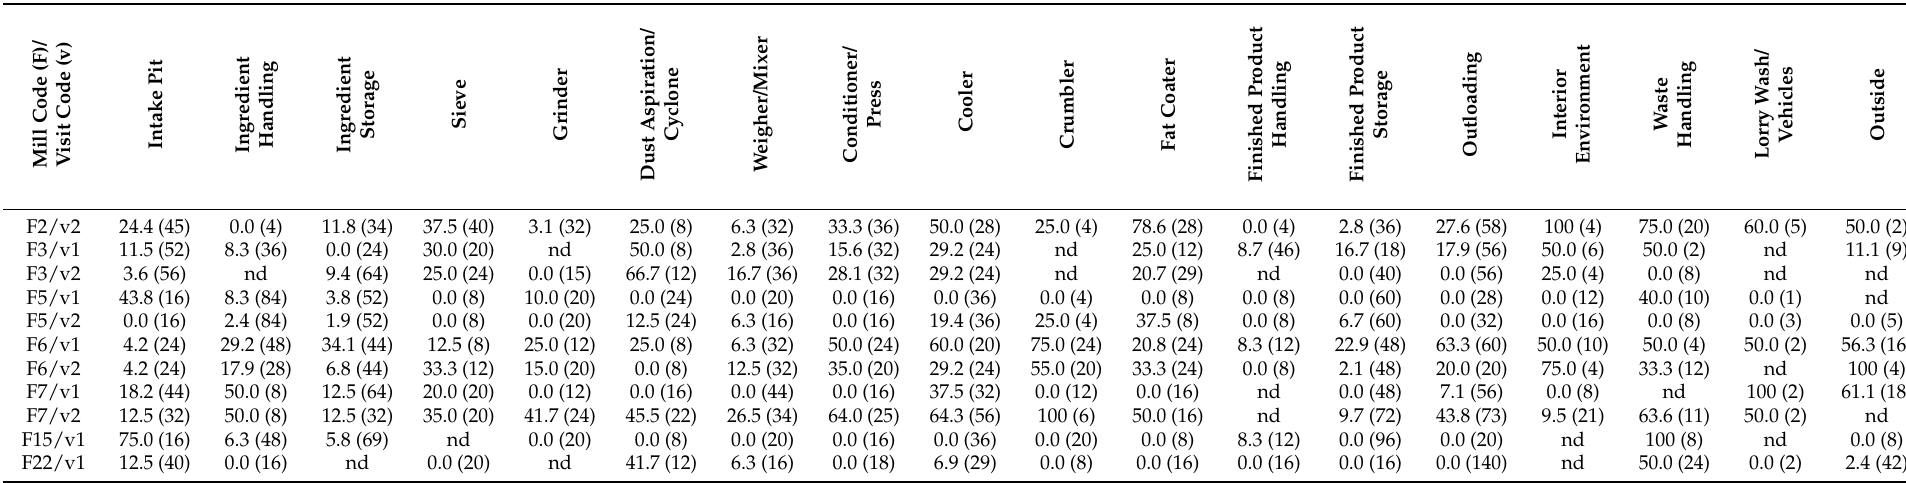
Table 2. Prevalence of Salmonella -positive samples by location, for feed mill visits where the organism was isolated from five percent or more of